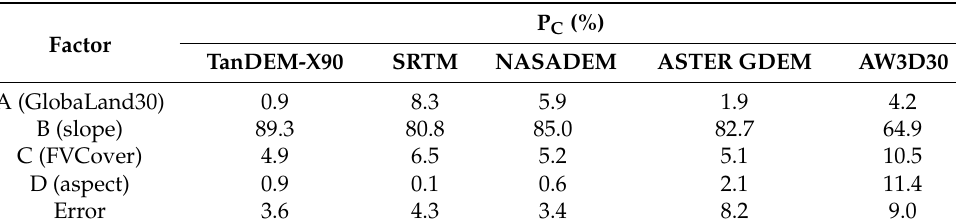
Table 6. The contribution to the DEM quality index MAE of each factor in the study area.